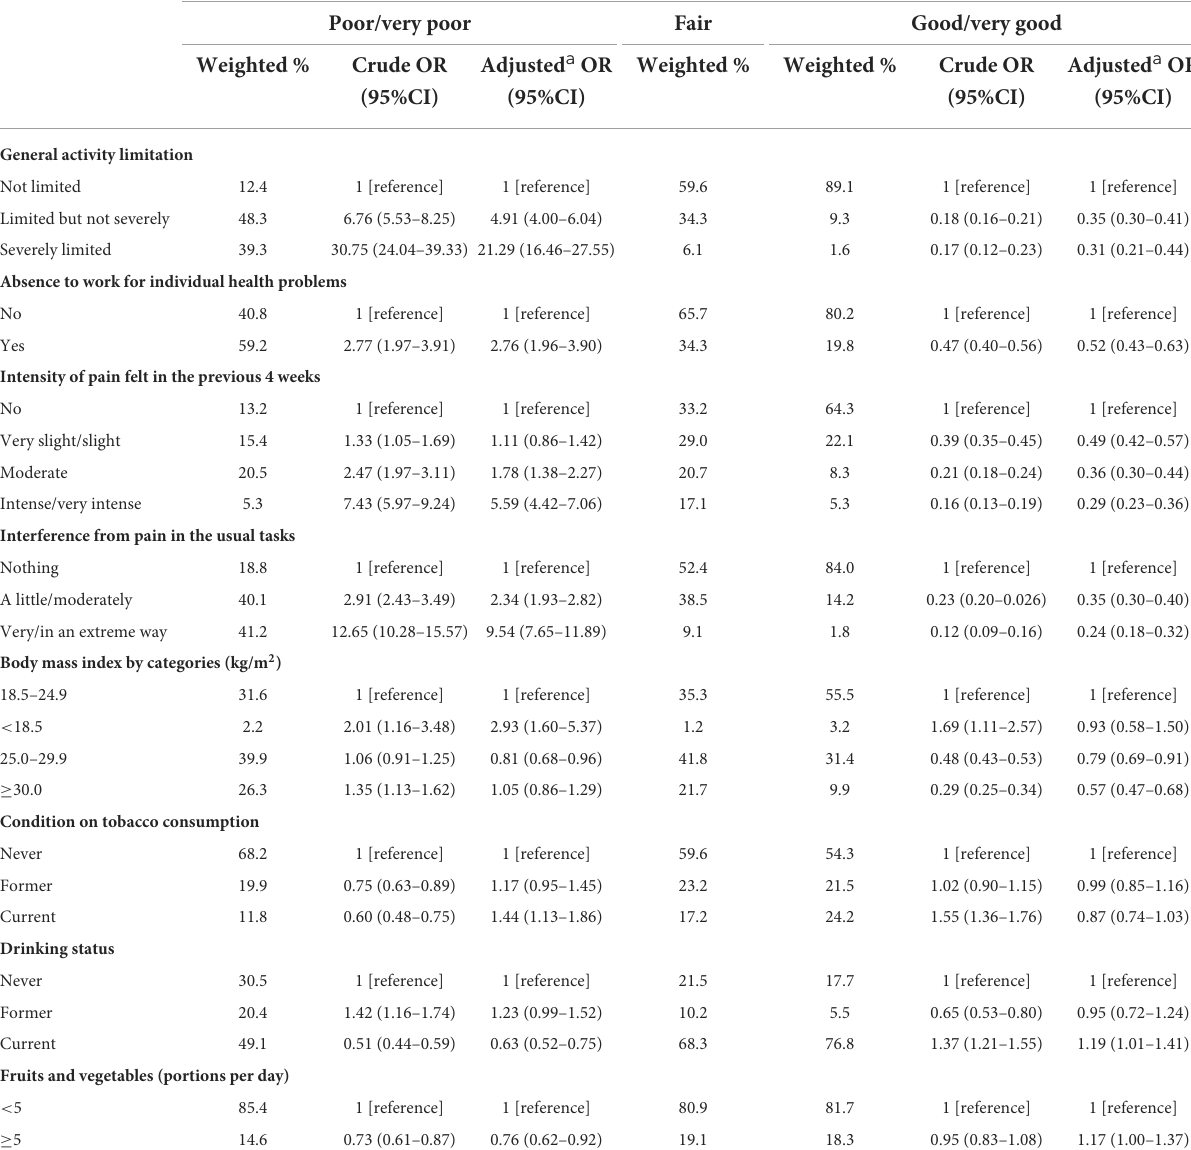
TABLE 5 Association between activity limitation and lifestyle factors, and self-perceived health status. Self-perceived health status Poor/very poor Fair Good/very good Weighted % Crude OR Adjusted a OR Weighted % Weighted % Crude OR (95%CI) (95%CI)